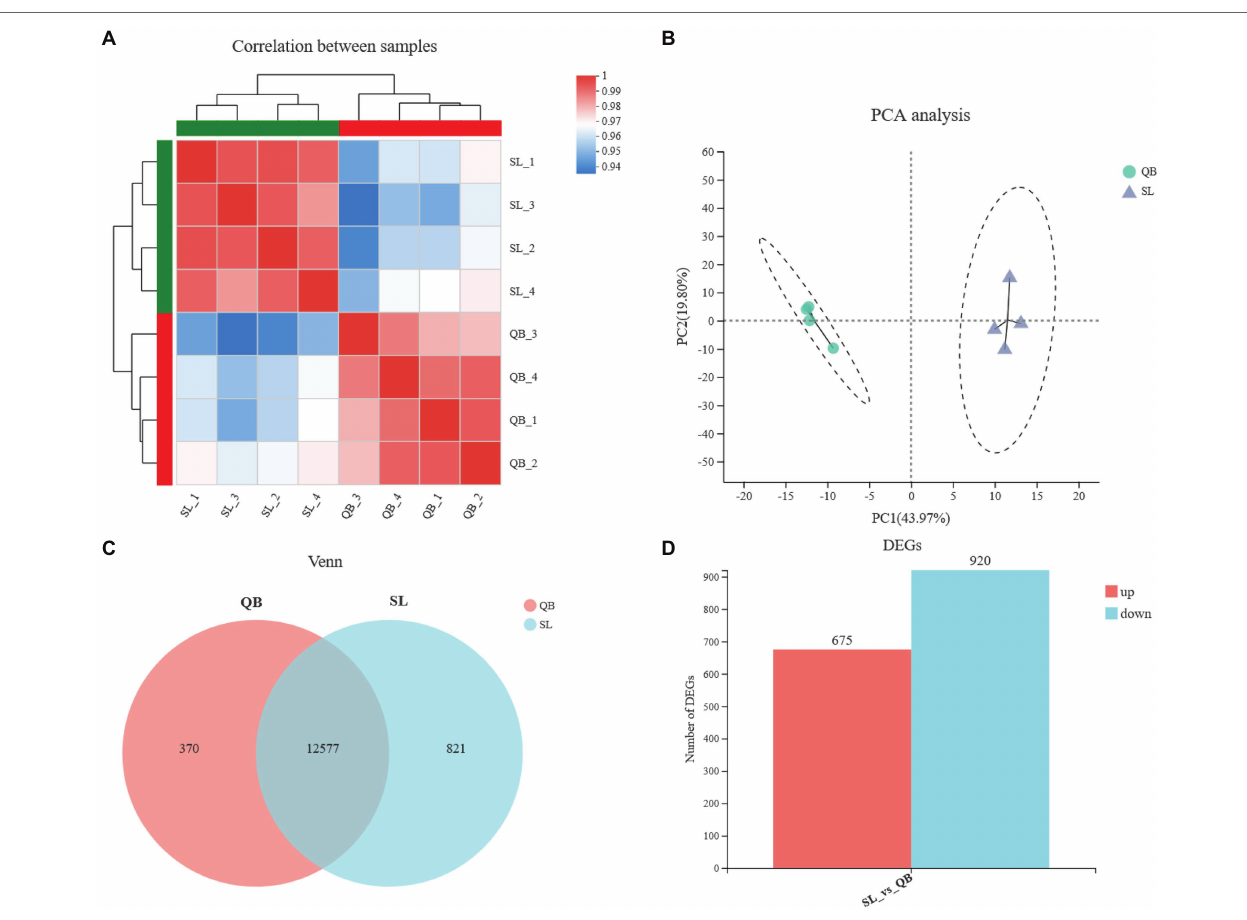
genes and 920 downregulated genes ( Figure 3D , the description of upregulation/downregulation was the result of gene changes in QB-G compared with SL-N).